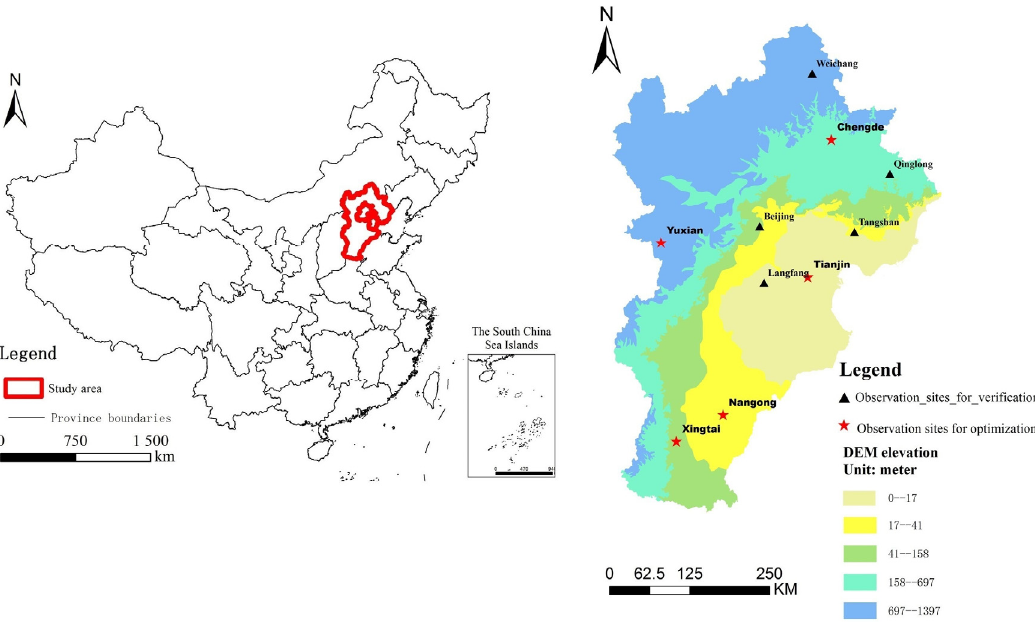
Figure 1. Study area and distribution of observation sites.